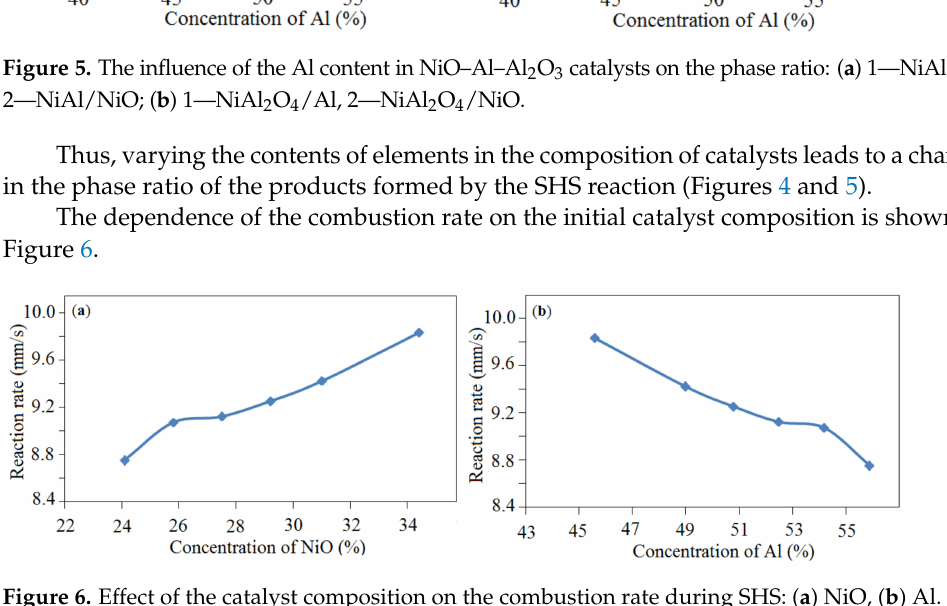
Figure 6. Effect of the catalyst composition on the combustion rate during SHS: ( a ) NiO, ( b )